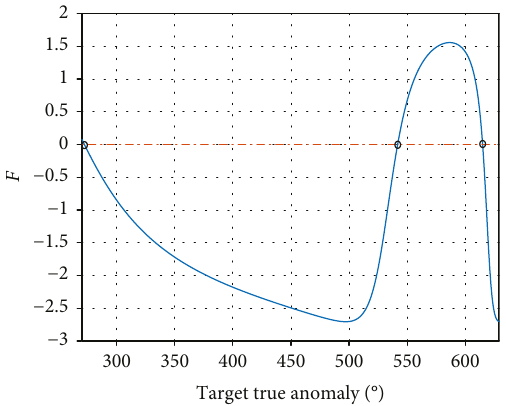
Figure 6: The F value corresponding to the true anomaly of the target at di ff erent interception